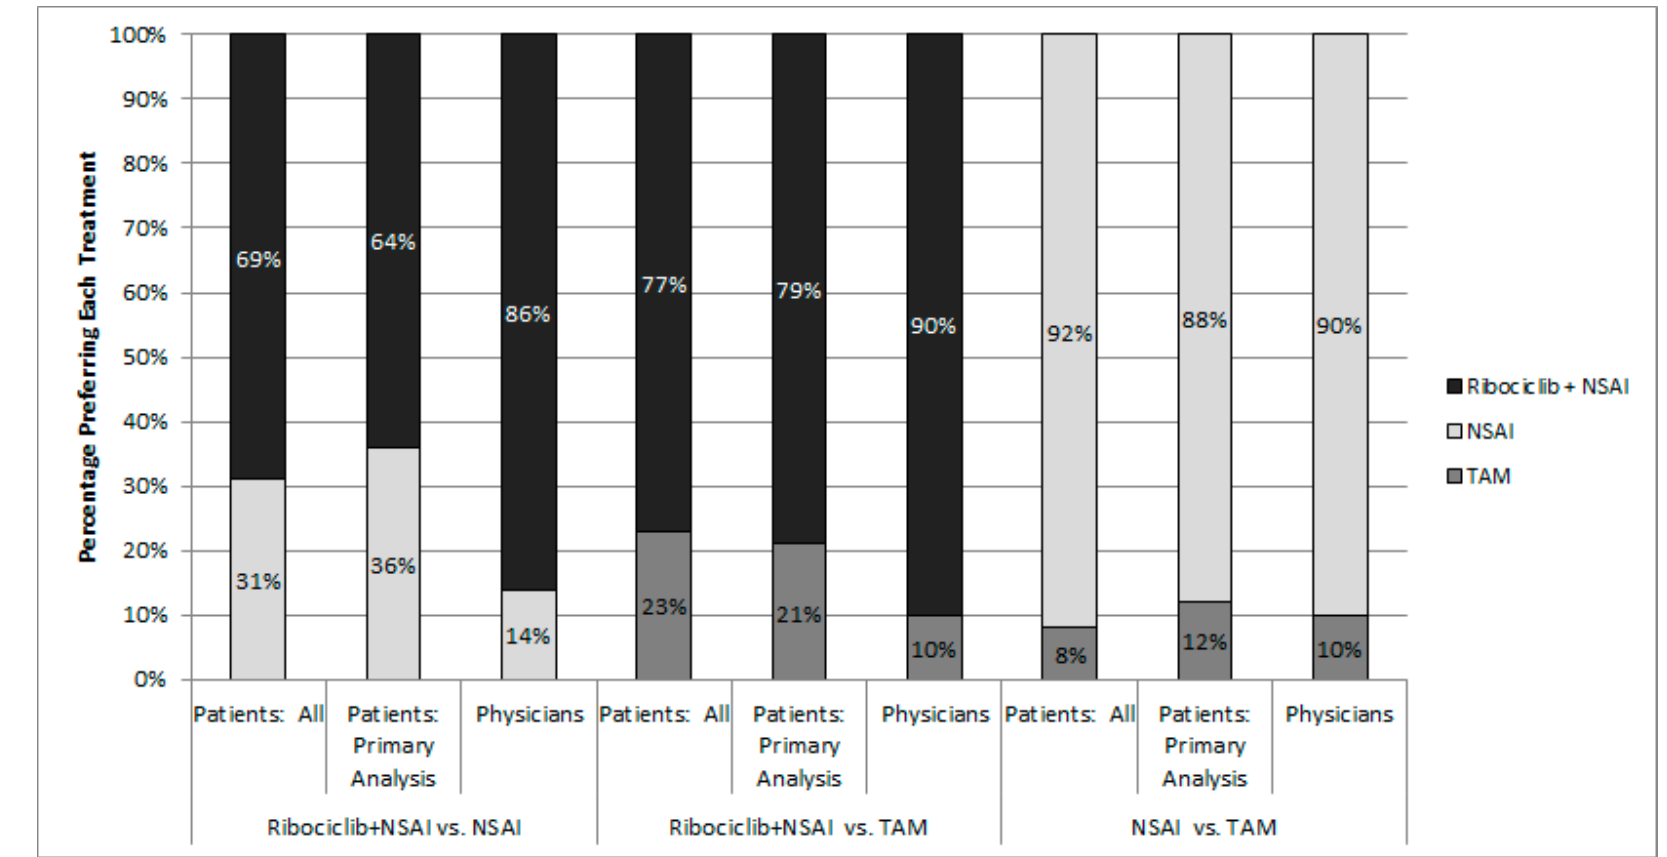
Figure 3. Choice of most preferred treatment in head-to-head comparison tasks; Note: Treatments were not identified by name in the survey.